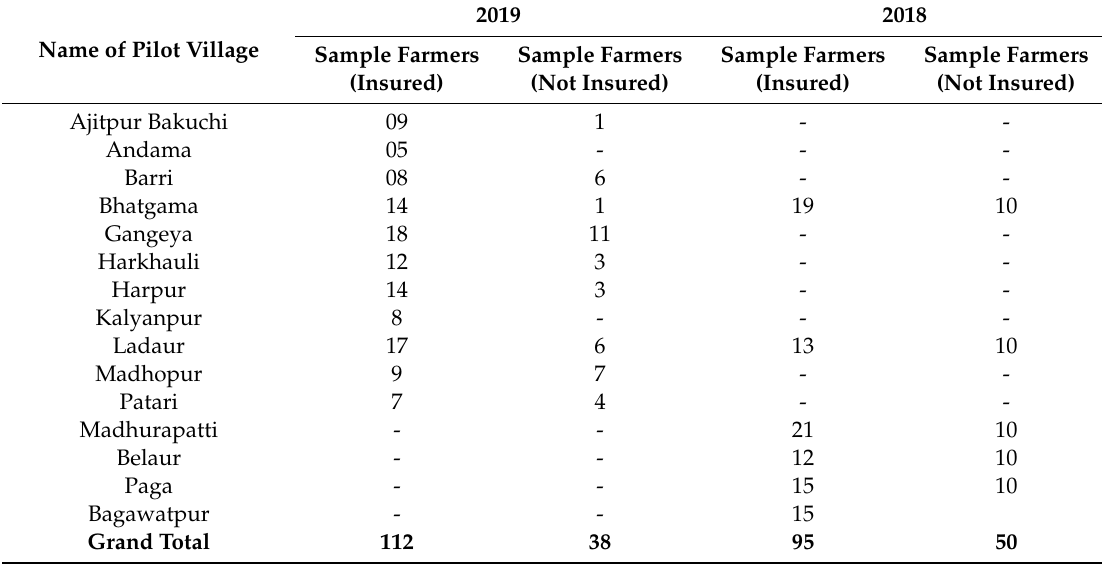
Table 2. Sample size of Bihar pilots in 2018 and 2019.